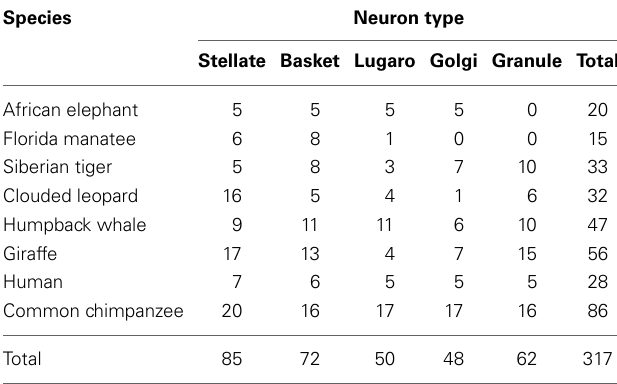
Table 1 | Number of tracings for each neuronal type within each